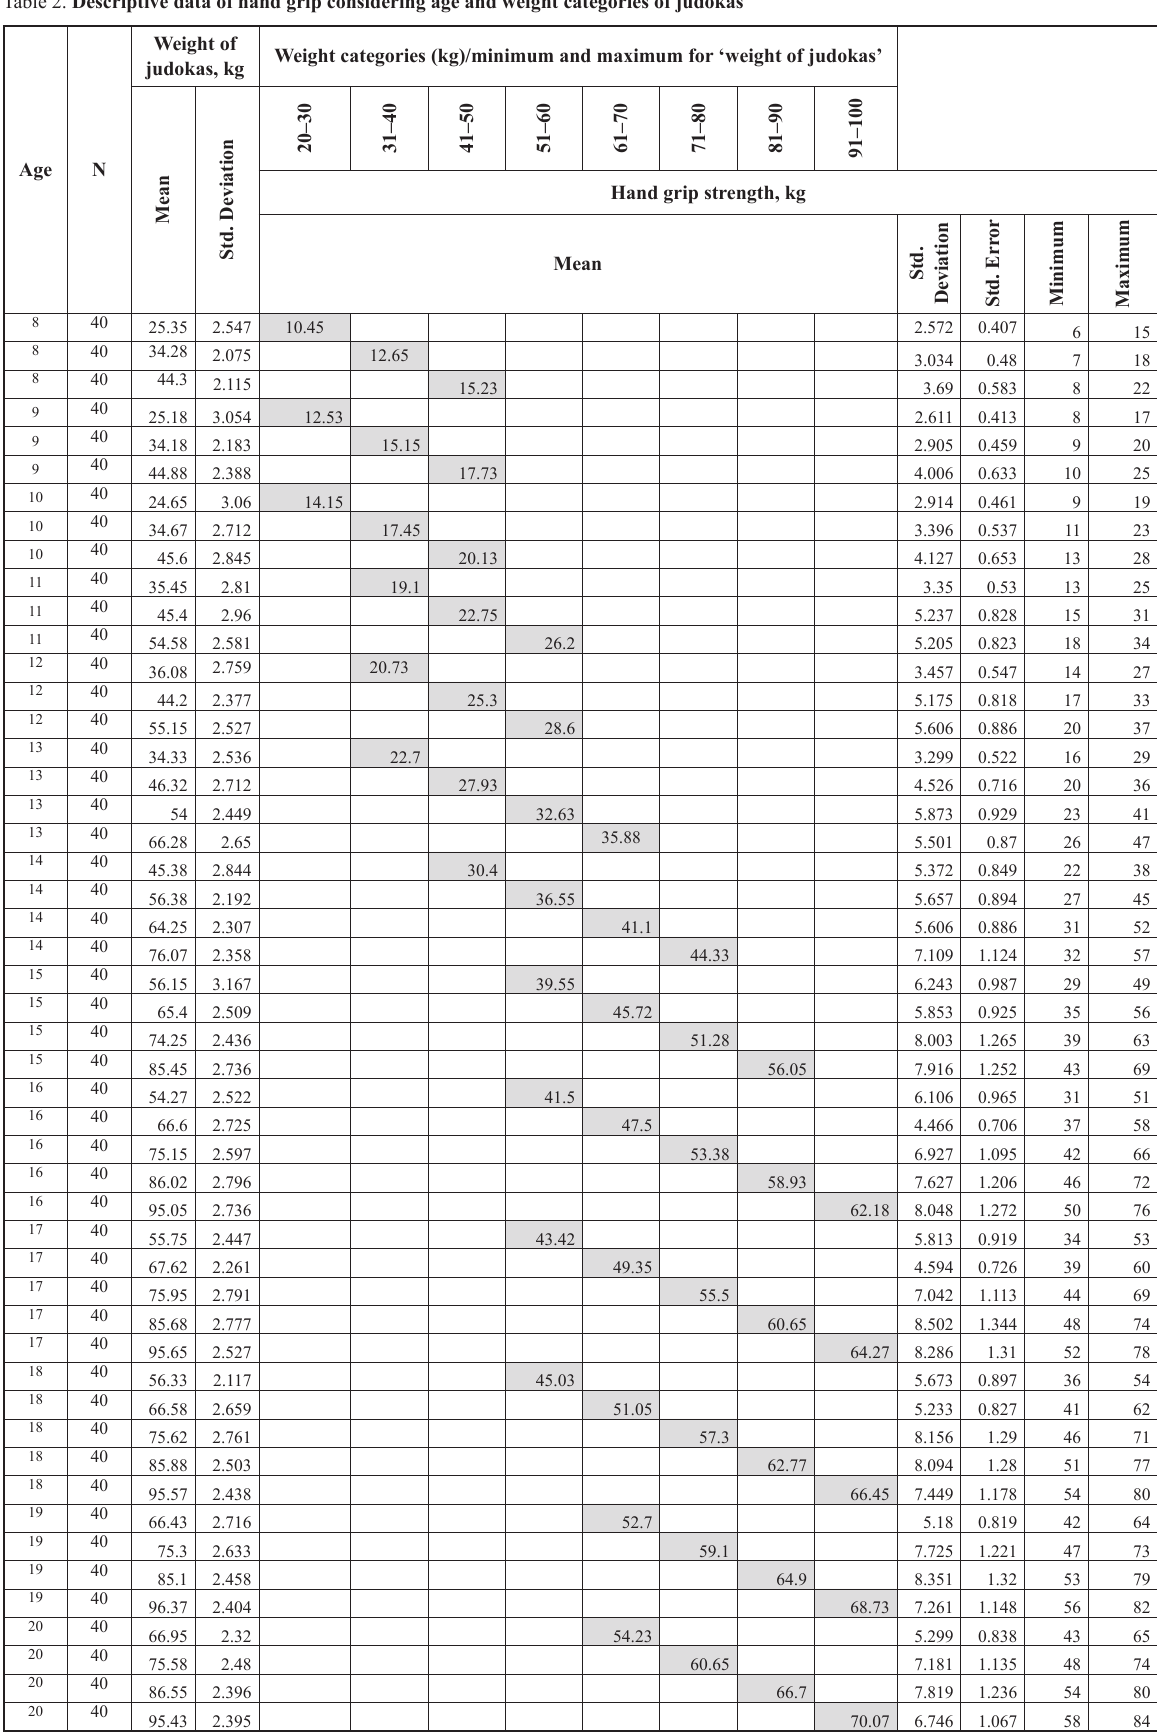
Table 2. Descriptive data of hand grip considering age and weight categories of judokas Weight of Weight categories (kg)/minimum and maximum for ‘weight of judokas, kg